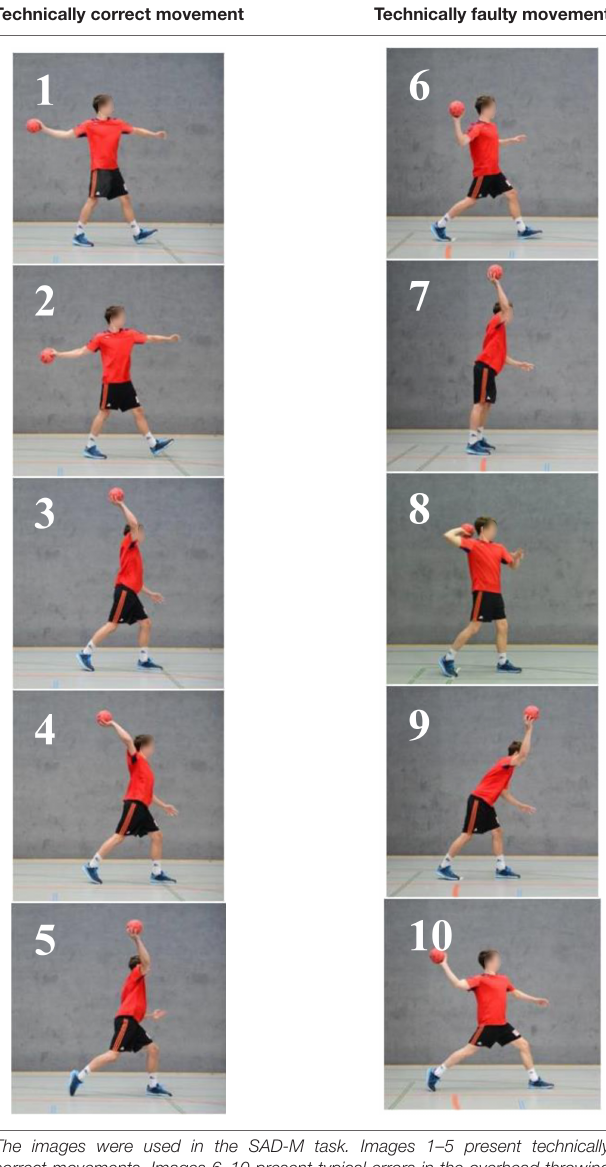
TABLE 2 | Results ( λ -values) of group analysis for cluster sets of each group.